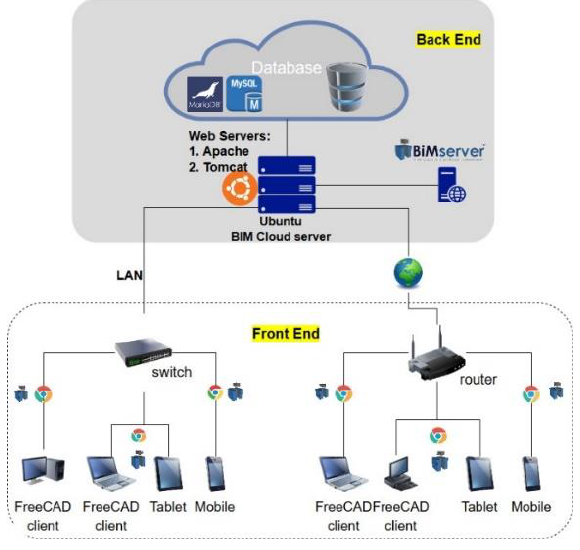
Figure 10. The proposed